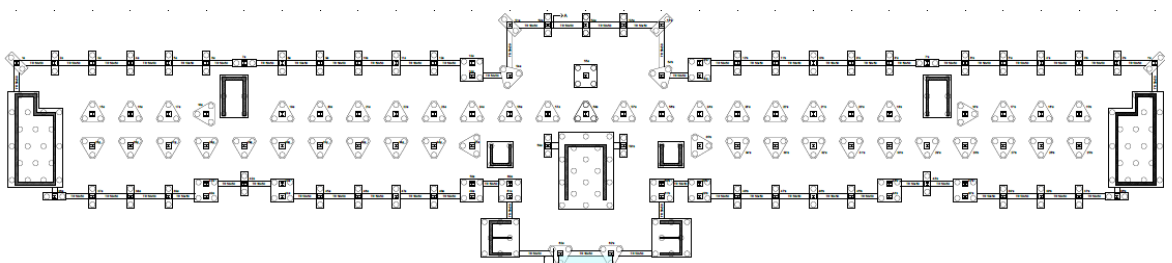
Figure 5. Foundation plan of the Day-Hospital